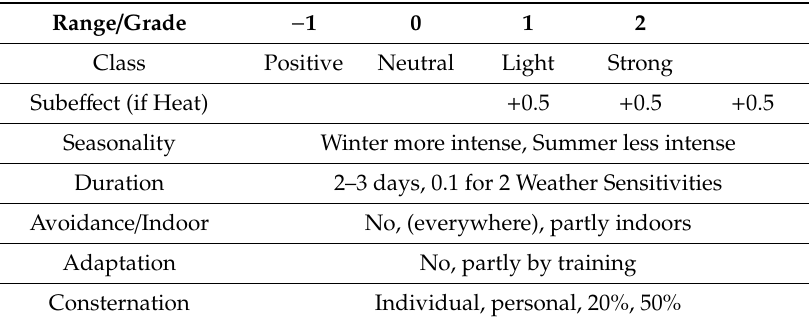
Table 3. Factors a ff ecting weather